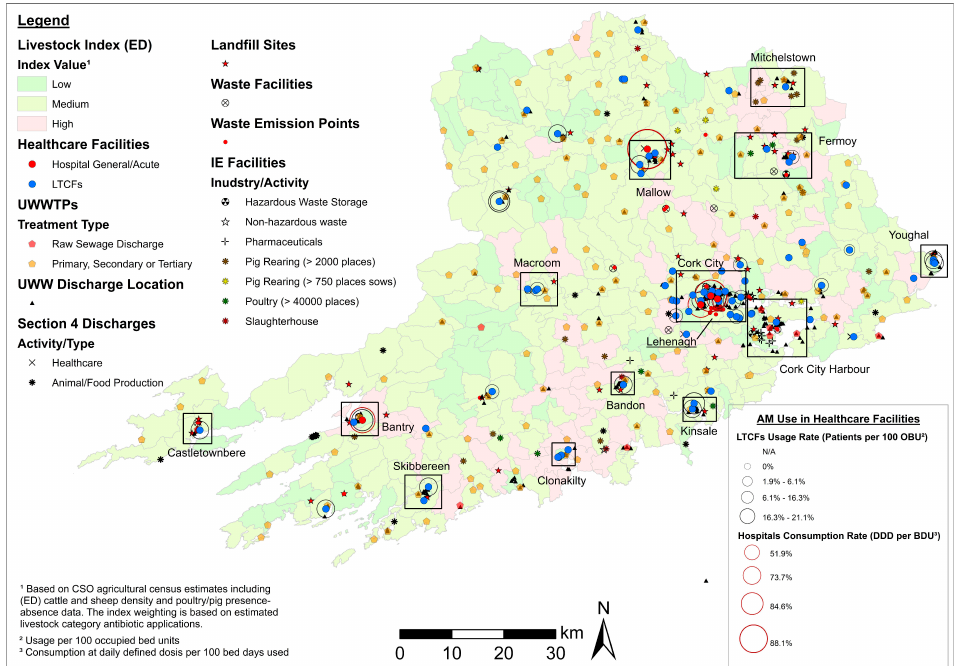
Figure 2. Map of potential ARO sources (classified) and healthcare facilities (including AM use) in County Cork. Notes: Livestock index estimates are included as a base map layer. Clusters of ARO sources are delineated with the location of Lehenagh—the ED with the highest number of ARO sources identified (highlighted). ED = electoral district. UWWTPs = urban wastewater treatment plants. UWW = urban wastewater. IE = industrial emissions. OBU = occupied bed units.